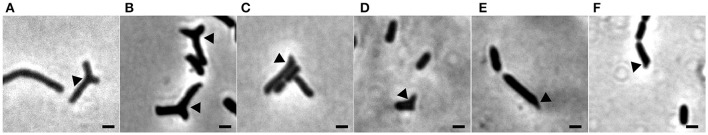
Phase contrast images showing branching of Xac ΔminC amy::gfp grown to exponential phase in different media. (A) Xam1. (B) Xamg1. (C) LB 0%. (D) LB 0.5%. (E) NYCB. (F) NYGB. Scale bar 1 μm.